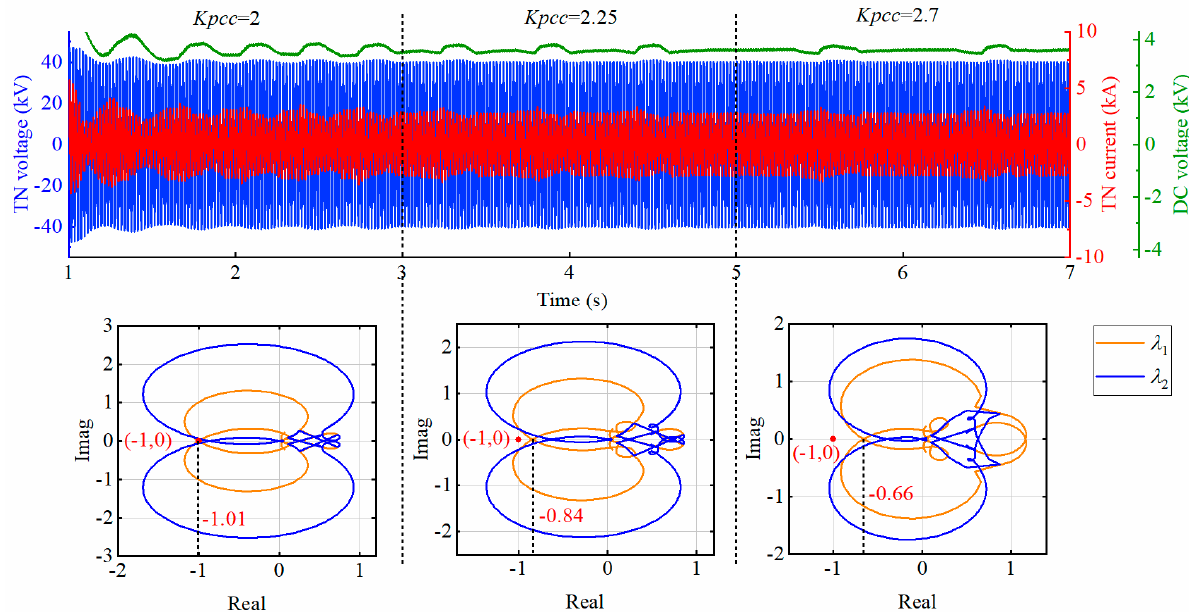
Figure 12. Influence of current loop PI proportional gain on system stability.